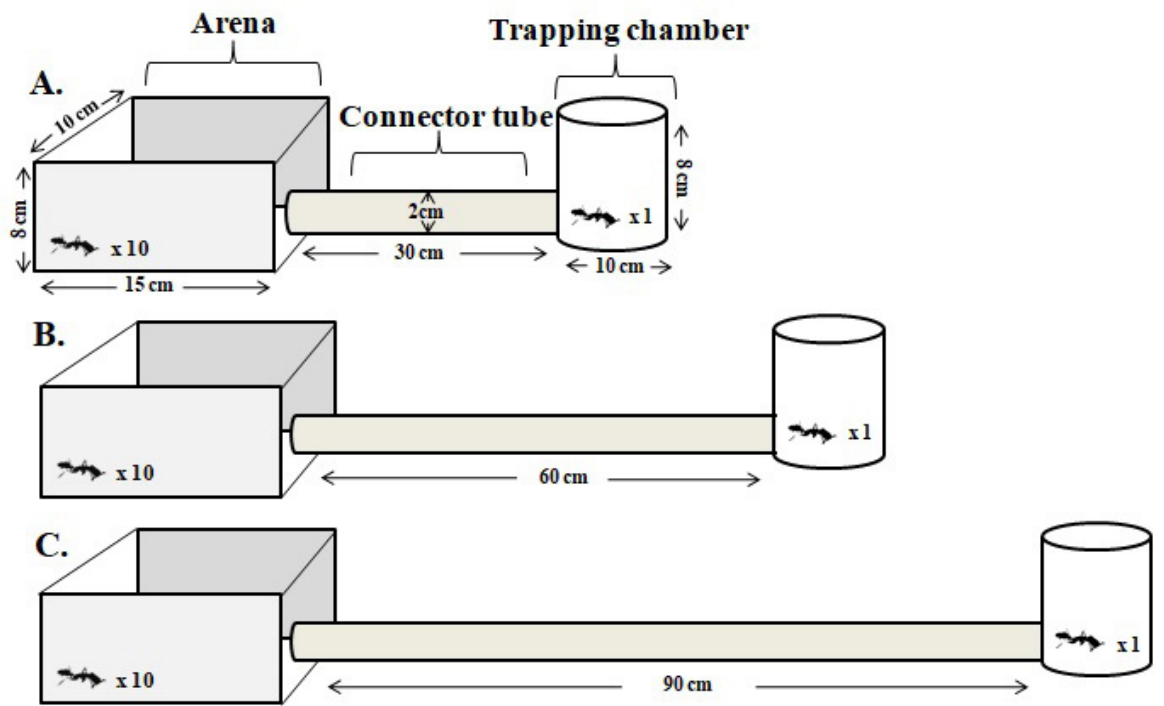
Fig 1 . Scheme used for the latency tests of rescue behavior between O. brunneus nestmates. A: Arena connected to the trapping chamber through a 30 cm connector tube; B: Arena connected to the trapping chamber through a 60 cm connector tube; C: Arena connected to the trapping chamber through a 90 cm connector